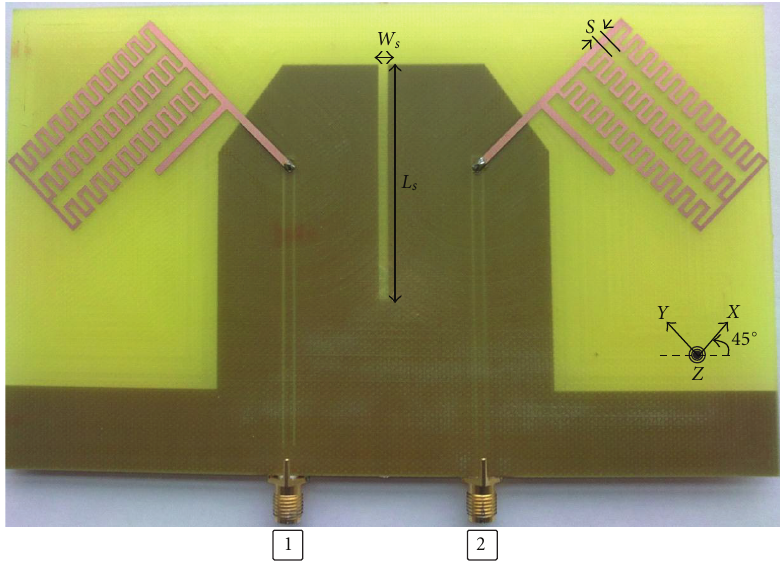
Figure 5: A photograph of the prototype with the three meander bend endings antennas.